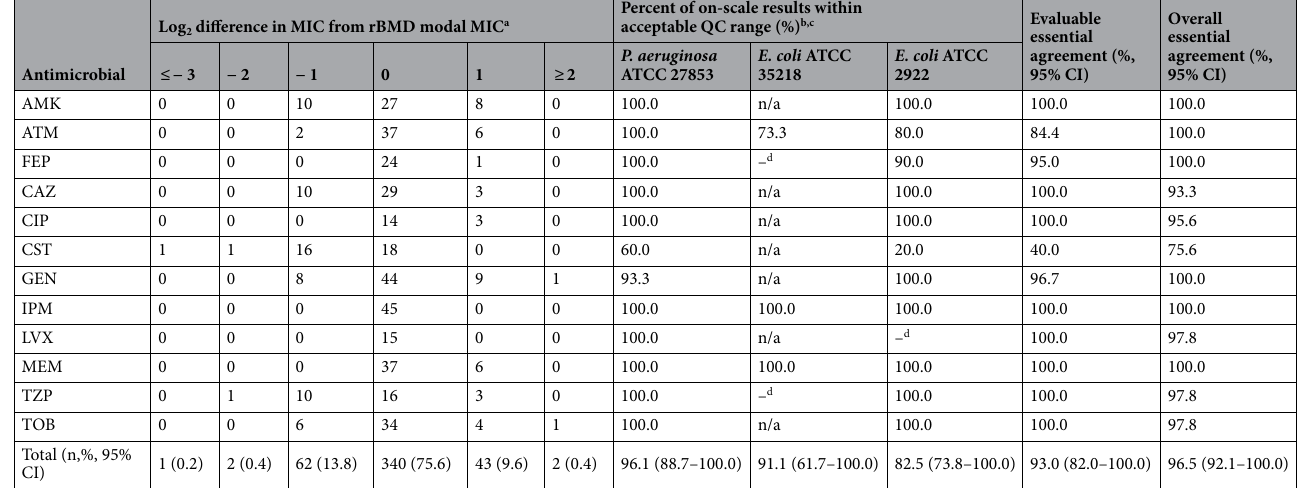
Reproducibility of D300e dispensed panels in quality control screens. Fifteen QC panels created by the D300e Digital Dispenser were compared to traditional rBMD using the CLSI-recommended E. coli ATCC 25922, E. coli ATCC 35218, and P. aeruginosa ATCC 27853 control strains. Of the 1080 MIC measurements collected, 79.1% of D300e and 81.2% of rBMD measurements were on-scale and used to evaluate EA (Table 2). The majority of on-scale D300e MICs (98.9%) were within a 1log 2 dilution of the modal MIC from comparable rBMD testing and in high evaluable essential agreement (Table 2). The percent of on-scale results within accept- able QC ranges stated by CLSI was 90.0% (range: 82.5 to 96.1). The overall EA which included both on- and off-scale measurements was acceptable at 96.5%, however variability was noted among the test organisms/anti- microbial combinations (Table 2). Individually all control strains had acceptable EA, with an average of 94.4% (range: 66.7–100.0%) for the E. coli ATCC 29522 strain, 95.0% (range: 60.0–100.0%) for E. coli ATCC 35218, and 100.0% (range: 100.0%) for P. aeruginosa ATCC 27853 (Table 2). Measurements for LVX for E.coli ATCC 25922, FEP and TZP with E. coli ATCC 35218 were off-scale and not included in the EEA analysis. Poor overall EA and EEA were observed with CST for both E. coli ATCC 25922 and P. aeruginosa ATCC 27853 strains in D300e created panels. While these data were in overall CA, individual CST D300e measurements were often spread over a ± 3 log 2 dilution range from the corresponding rBMD measurements. In contrast, the MICs measured for the P. aeruginosa ATCC 27853 strain were highly reproducible in all tests (Table 2). Despite the discordance in CST QC (Table 2), the D300e dispensed panels had excellent CA with the rBMD method for all strains, with no categorical discrepancies noted for any antimicrobial (100% CA for all antimicrobials/QC strain pairings). Performance of D300e panels with clinical P. aeruginosa isolates. Isolates from the verification panel (Figure S1) were found to display a wide array of antimicrobial-associated phenotypes, with resistance to any of the 12 antimicrobial agents being documented for at least one isolate (as determined by rBMD) (Table S1, Table S2). The most active antipseudomonal agents were CST, MEM and TZP (with 98.0, 69.0 and 72.0% of iso- lates being susceptible, respectively), while GEN was the least active (42.0% of isolates displaying susceptibility) (Table S2). Eighty-one percent of the D300e MICs were on-scale and within 1log 2 dilution of the corresponding rBMD value. In general, MICs from D300e dispensed panels correlated well with rBMD panels, yielding an average Spearman correlation coefficient of 0.93 (range: 0.77 to 0.97, n = 1200 per panel type) (Fig. 1). The D300e and rBMD methods were found to have the greatest variability in mean MIC for AMK, CAZ and TZP (Figure S2). There was an average overall EA and EEA of 92.7% for all antibiotics tested, with the highest EA and EEA for the aminoglycosides and fluoroquinolones (97.0 and 96.0% respectively) and the lowest EA for CST (84.0%) (Table 3). Despite the overall high agreement, measurements for only eight of the 12 antimicrobials were in acceptable (≥ 90%) overall EA and EEA. Some β-lactams had the greatest variation in measurement, with low EA and EEA for ATM, CAZ and TZP. In contrast, the carbapenems MEM and IPM were both acceptable 13,15 . We noted that MICs that differed between methods (i.e. the same MIC in µg/mL was not reported in both methods) were typically 1 log 2 dilution lower in D300e panels, which accounted for 35.8% of the total measurements. When examining the distribution of MICs among isolates, rBMD MICs were often at breakpoint concentrations for